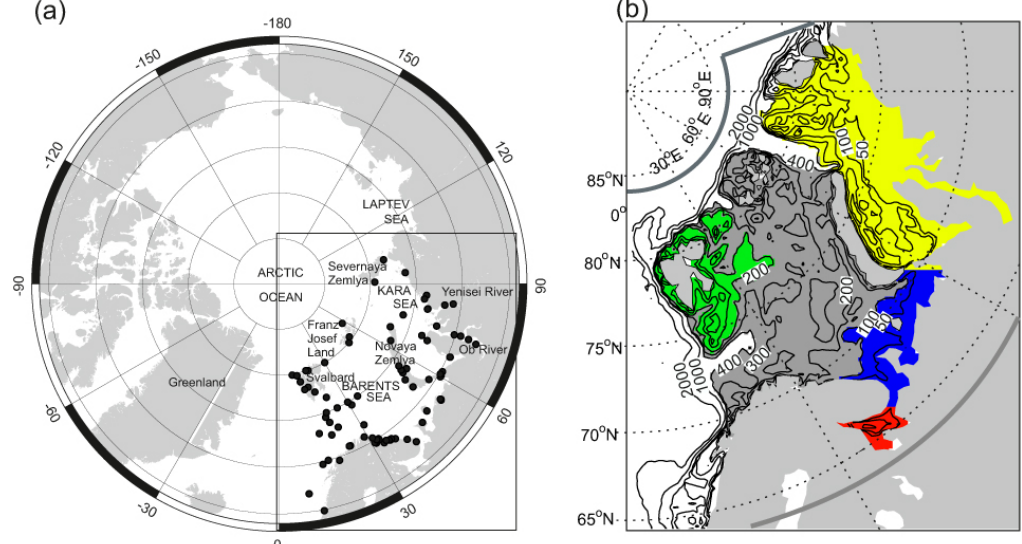
Fig. 2. (a) Polar stereographic projection of the Arctic showing the study region. Black dots indicate the location of tide gauges. (b) Bathymetry of the Barents and Kara Seas domain. The 400m contour is taken to be the boundary of the continental shelf region. The grey line shows the edge of the model domain. Colors indicate subdomains used in this study (the Kara Sea is shaded yellow, the White Sea is red, the Pechora Sea is blue, the region around Svalbard is green and the rest of the Barents Sea is